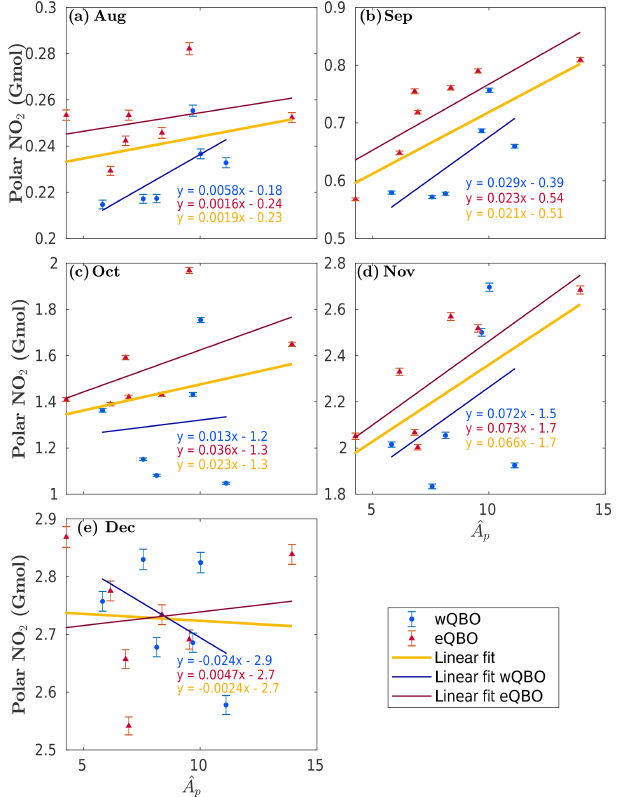
Figure A1. The same as Fig. 4 but with the monthly average polar NO 2 expressed in gigamoles (Gmol). Each panel shows the linear least squares fit to data points (colour coding is the same as that in previous figures), including the fit equations ( y = NO 2 , x = ˆ A p ). Red triangles are years with eQBO, and blue circles are years with wQBO. The yellow linear fit is a best-fit line for all of the data in each plot, the red line fits only eQBO data, and the blue line fits only wQBO